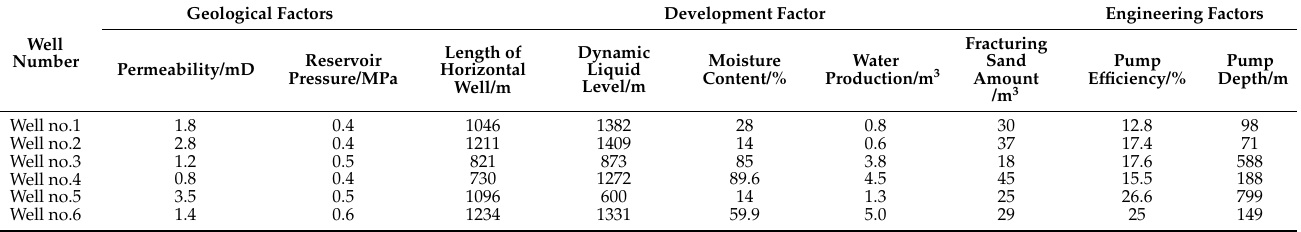
Table 2. Parameter statistics of partially fractured horizontal wells in a block of the Daqing